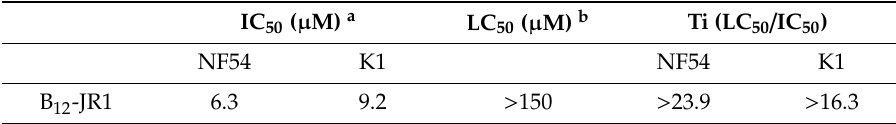
Figure 6. Toxicity evaluation of B 12 - JR1 and B 12 - JR1-CBC in the zebrafish model over a period from 6 to 120 hpf, expressed as the LC 50 values. Shown are data relative to ( A ) embryos survival / teratogenicity and ( B ) cardiotoxicity. The liver is outlined with a dashed line. Table 2. Therapeutic windows of B 12 - JR1 for NF54 strain (CQ-sensitive) and K1 strain (CQ-resistant) of P. falciparum